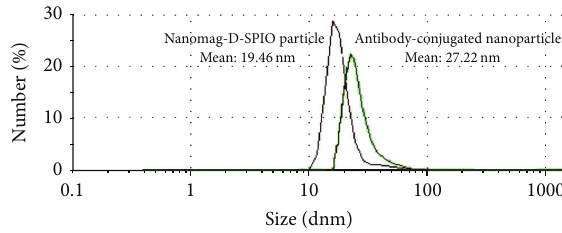
Figure 2: Nanoparticle size before and after conjugation